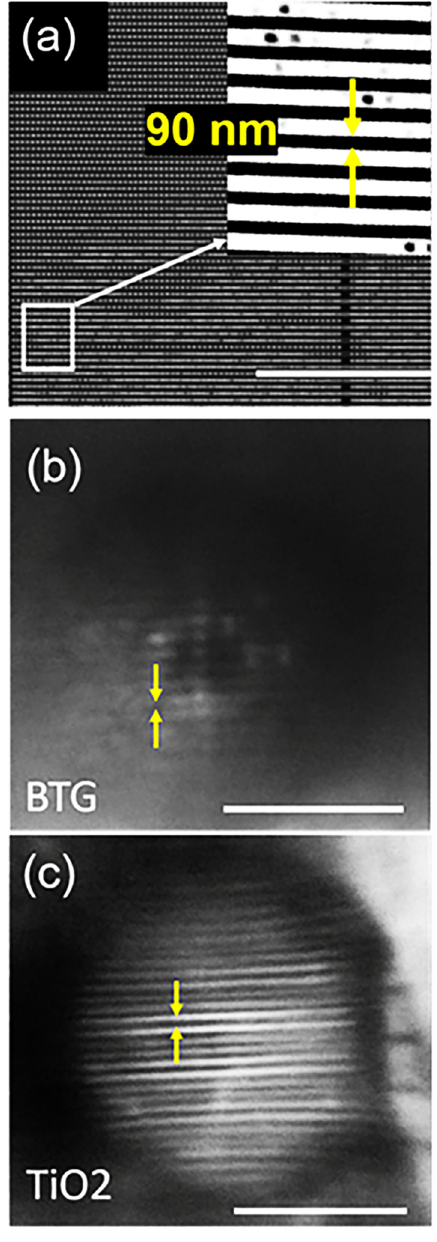
Figure 5. ( a ) SEM image of wafer pattern with 90 nm spacings, while the inset shows the magnified image of marked region. ( b , c ) Optical microscopic images of wafer pattern shown in ( a ) through BTG and TiO 2 microspheres, respectively. Scale bar: 10 μ m.